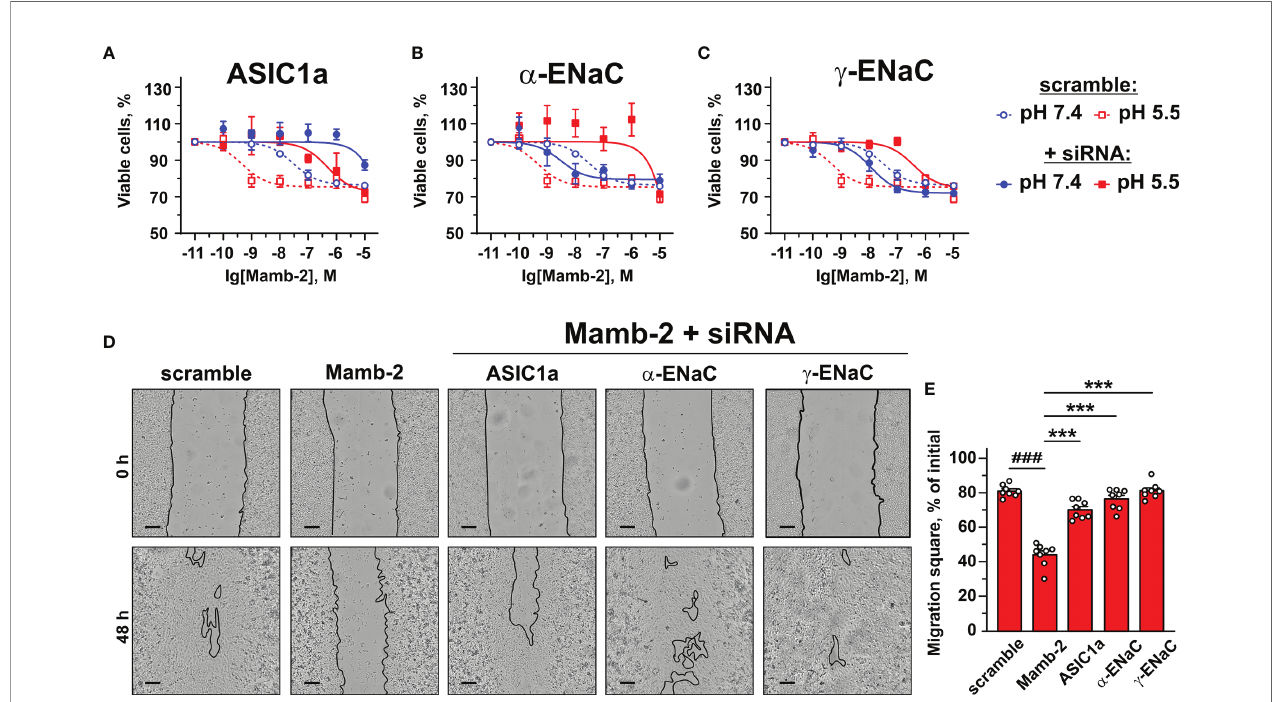
FIGURE 8 | In fl uence of knockdown of ASIC1, a -ENaC, and g -ENaC expression on mambalgin-2 activity in A549 lung cancer cells. Dose – response effects of mambalgin- 2 on viability of A549 cells after cell transfection with scramble siRNA or siRNA speci fi c for ASIC1a (A) , a -ENaC (B) , and g -ENaC. (C) Data are presented as % of the control (untreated cells) ± SEM (n = 4). The gene knockdown con fi rmation is shown in Figures S1A – E , and the analysis of dose – response curves is given in Table 1 . (D) Representative pictures of wounds for A549 cells incubated at pH 5.5 in the presence of 1 µM of mambalgin-2 upon knockdown of ASIC1a, a -ENaC, and g -ENaC genes. Scale bar = 100 µm. Analysis of gene knockdown in fl uence on the migration of A549 cells in the absence of mambalgin-2 is given in Figures S1F, G . (E) Wound area occupied by migrating A549 cells. Data are presented as % of the wound surface, occupied by migrating cells ± SEM (n = 8); ### (p < 0.001) and *** (p < 0.001) indicate signi fi cant difference between the data groups by one-way ANOVA followed by Tukey ’ s post-hoc